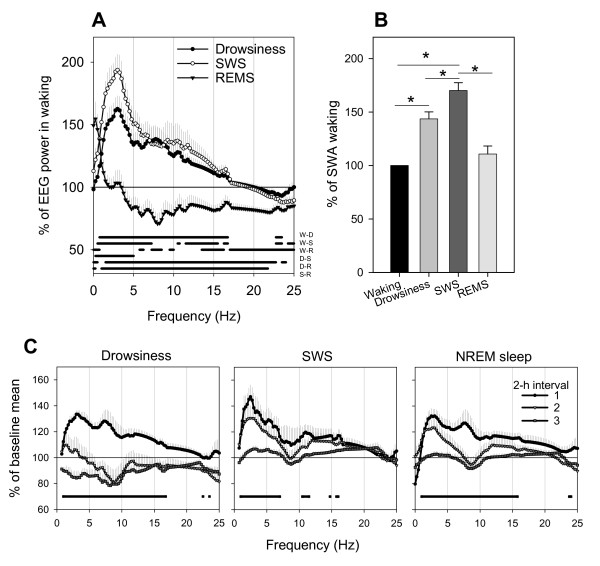
Differences in the EEG power spectrum between vigilance states during the baseline dark period. A. The relative EEG power spectrum of drowsiness, SWS, and REM sleep is plotted as percentage of the waking EEG power spectrum. Spectra refer to the first 6 hours of the dark period for all vigilance states except REM sleep, where the entire dark period contributed to the average spectrum. Values are means (± SEM, n = 6) of relative power density for each frequency bin (0.25 Hz, range: 0–25 Hz). The horizontal bars above the abscissa indicate frequency bins that differed significantly between vigilance states (p < 0.05, 2-tailed paired t-test). Waking (W), drowsiness (D), SWS sleep (S) and REM sleep (R). B. Mean slow wave activity (SWA, 0.5–4 Hz) in drowsiness, SWS and REM sleep expressed as percent of SWA in waking. Asterisks denote significant differences between states after correction for multiple comparisons.C. Time course of the EEG power spectrum in drowsiness and SWS and the two states combined (NREM) for the first three 2-hour intervals of the dark period. For each frequency bin (0.25 Hz) values are expressed as means (± SEM, n = 6) relative to the mean EEG power spectrum in that bin over the entire dark period in the corresponding vigilance state. Horizontal bar depicts frequency bins where 1-way repeated measures ANOVA (factor "time interval") was significant (p < 0.05)